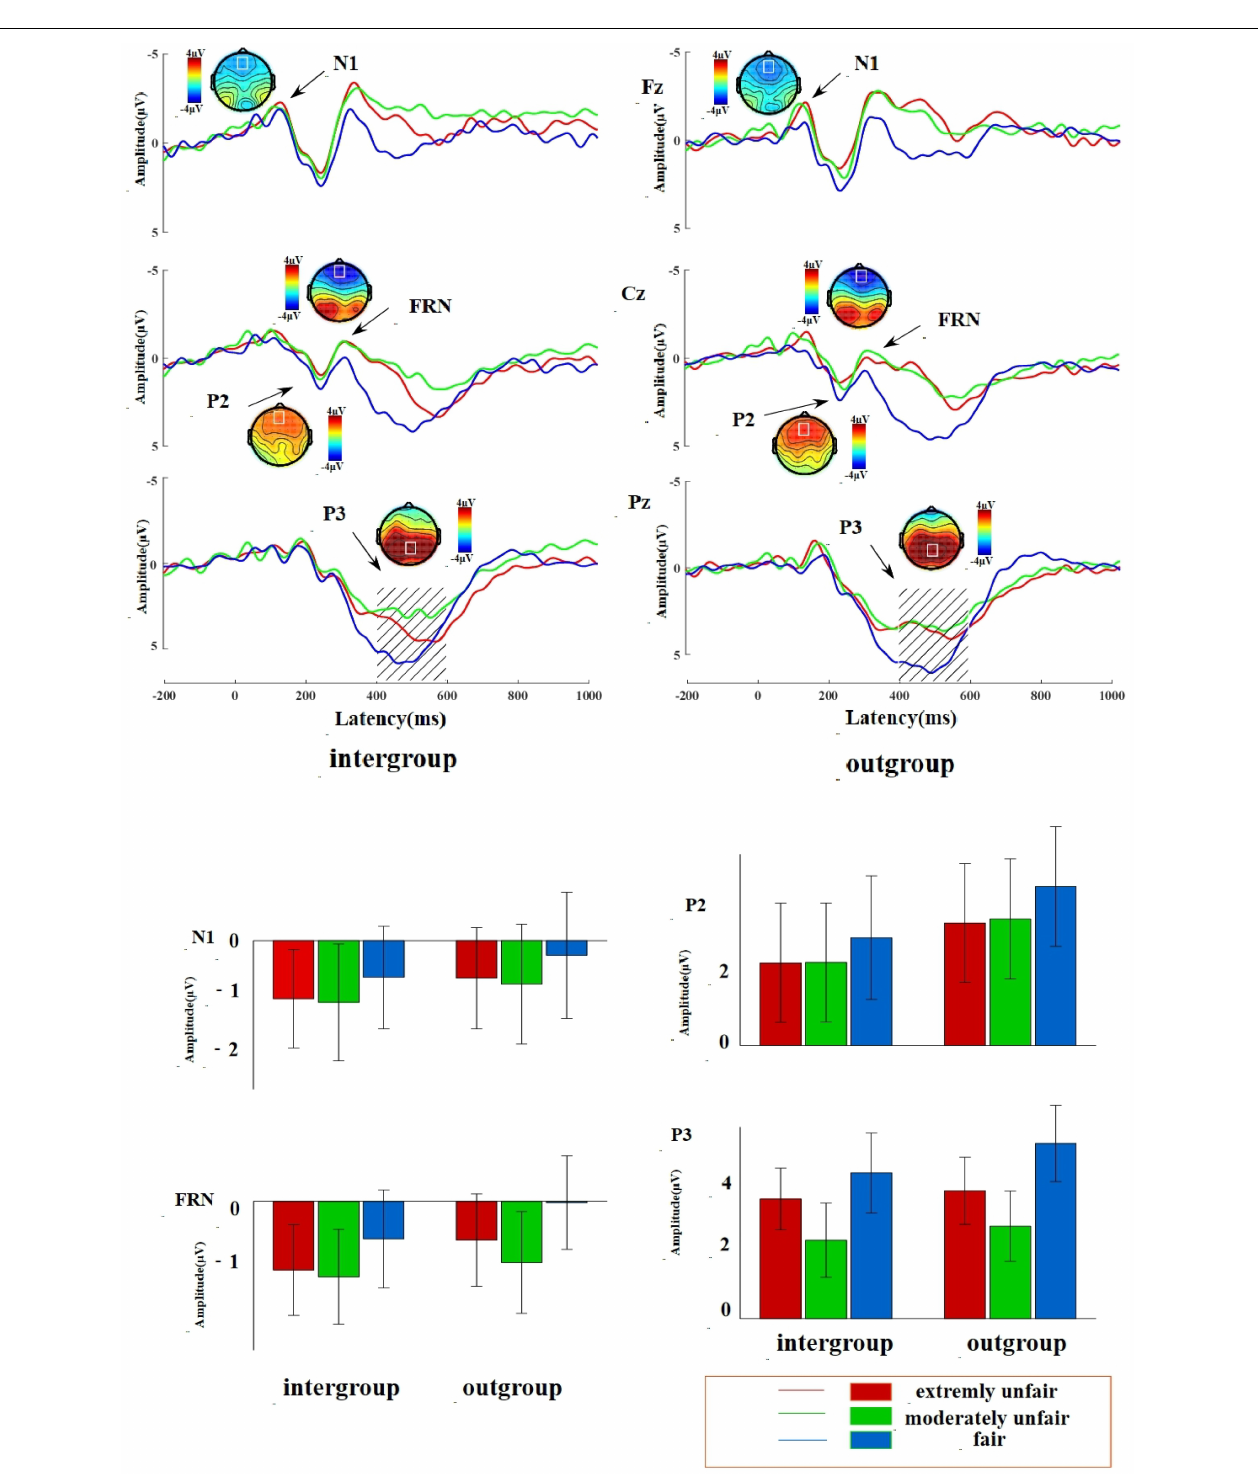
FIGURE 2 | Topographic waveforms and histograms of different group relationships, with topographic waveforms at the upper part and histograms at the lower part. The above picture shows the electroencephalogram (EEG), topographic map, and bar chart of deaf college students and healthy listening college students under different proposal types; the upper part of black solid line is divided into topographic map and waveform map and the lower part is divided into bar chart; the red solid lines and bars represent extremely unfair conditions, the green solid lines and bars represent moderate unfair conditions, and the blue solid lines and bars represent fair